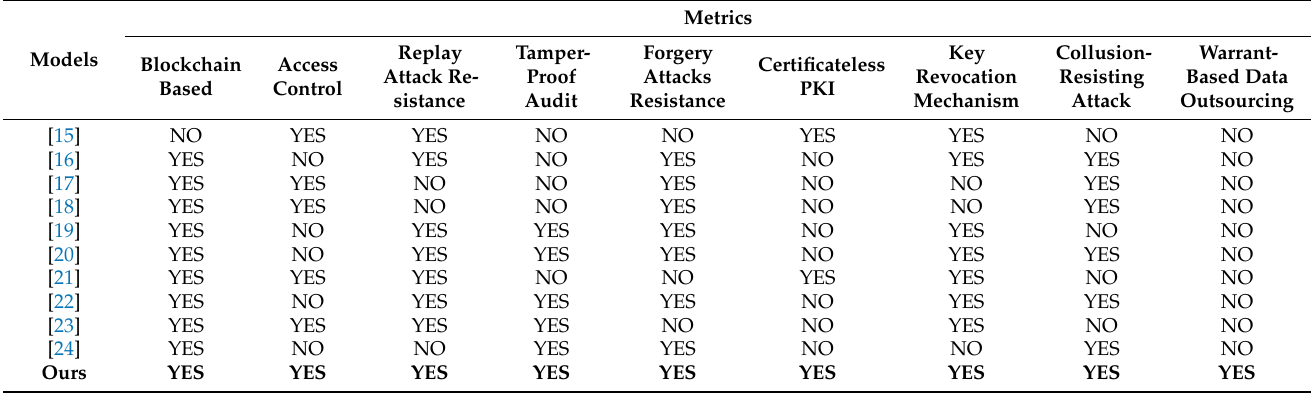
Table 5. Comparison of our model with other blockchain-based related existing systems.